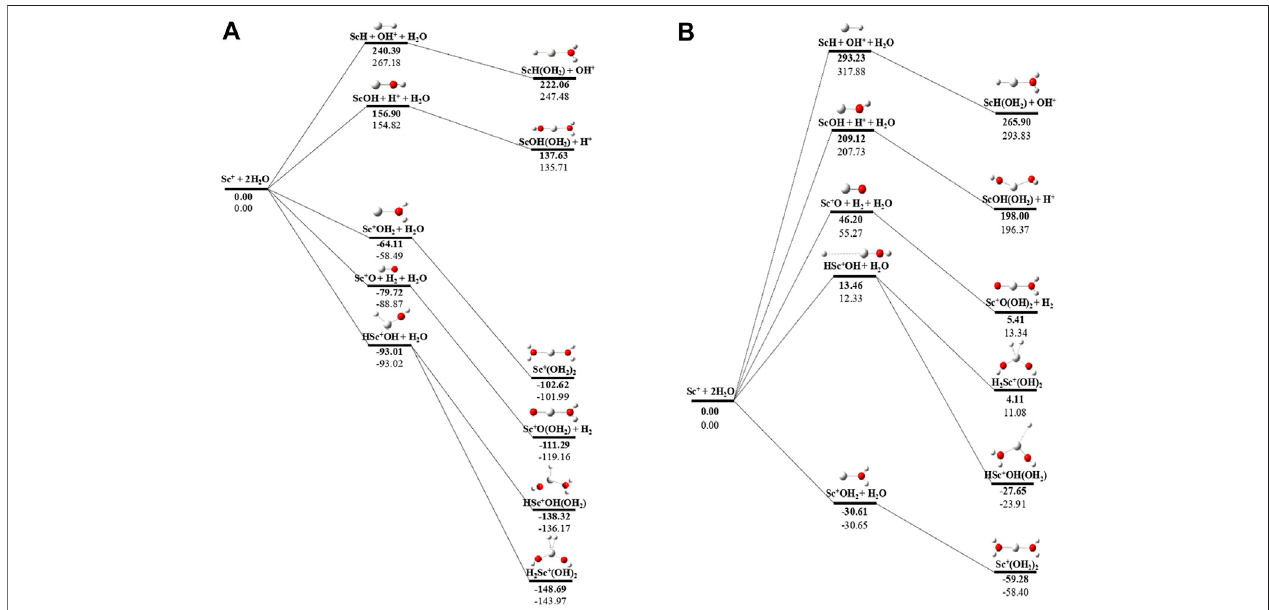
FIGURE 5 | CCSD(T)/6-311G**//MP2/6-31G* (bold) and MP2/6-311G**//MP2/6-31G* (normal) energies (kcal/mol) for (A) singlet-state (SS) and (B) triplet-state (TS) potential energy surfaces following Sc + + 2H 2 O reactions. The sum of reactant pair energy (Sc + + 2H 2 O) is considered as a standard (energy zero) to calculate the relative